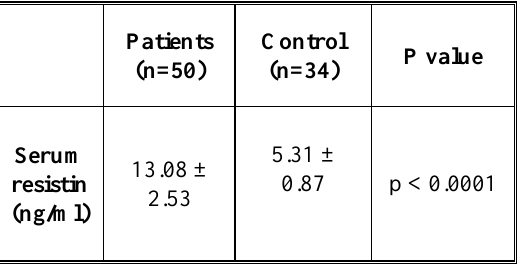
Values are presented as mean ± SD; n=number of patients.